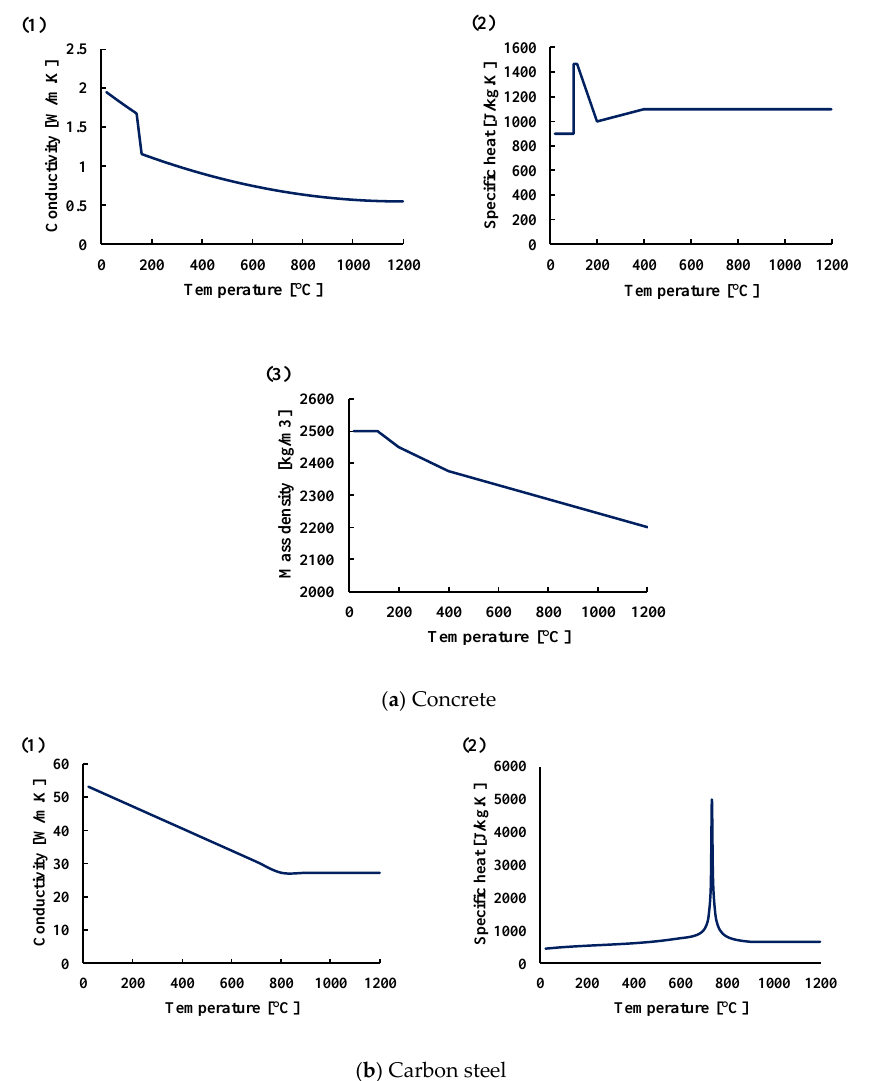
Figure 6. Variation of thermal properties of concrete and carbon steel. Subfigures (1) in subfigures ( a , b ) of Figure 6 represent the variation of conductivity with temperature for concrete and carbon steel respectively. Subfigures (2) in subfigures ( a , b ) of Figure 6 represent the variation of specific heat with temperature for concrete and carbon steel respectively. Subfigure (3) in subfigure ( a ) of Figure 6 represent the variation of mass density of concrete with temperature.